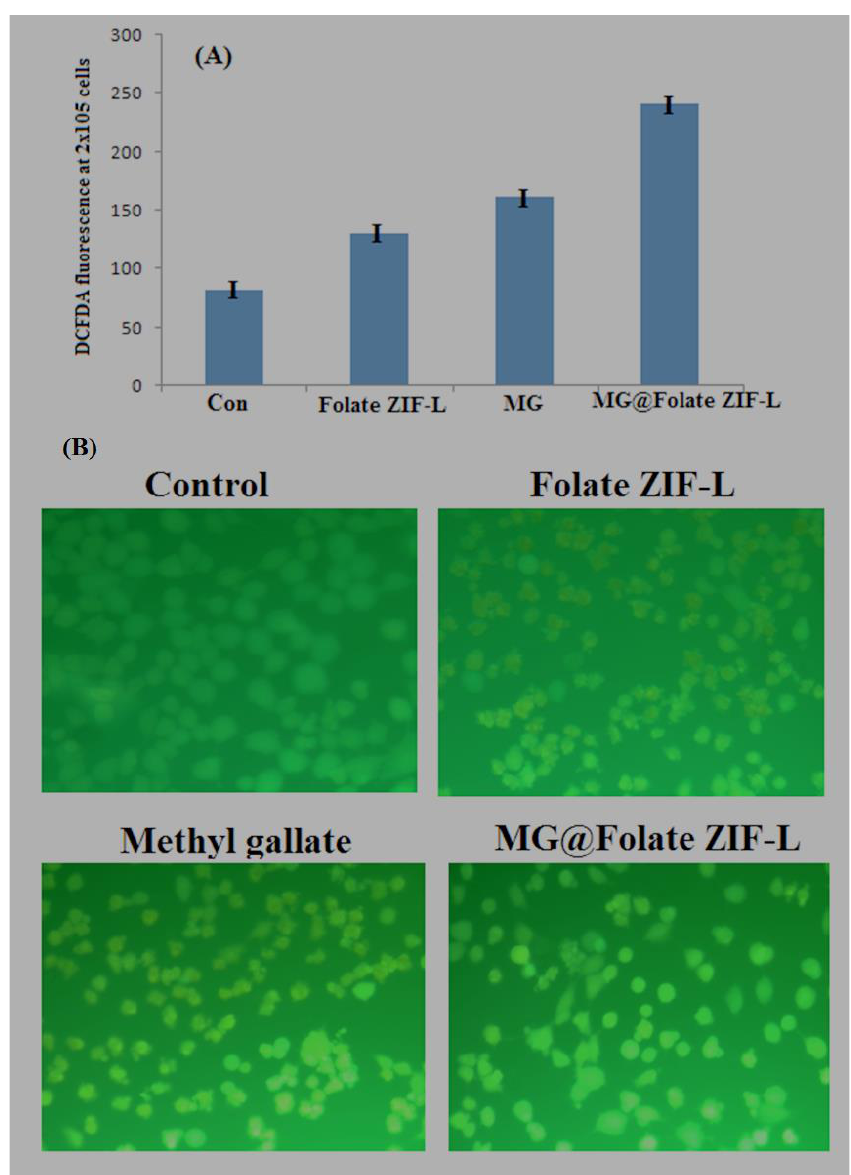
Figure 11. ( A ) Quantification of ROS level in A549 cells using fluorescence spectroscopy; ( B ) micro- scopic images of A549 cells post exposure of MG@Folate ZIF-L nanoframeworks induced intracel- lular ROS.